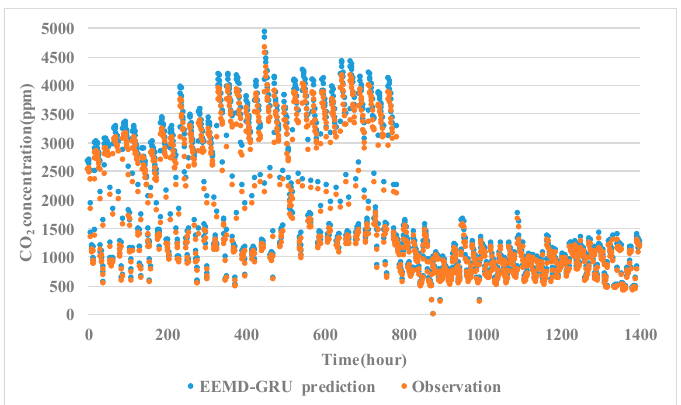
Figure 9. Scatter plot of EEMD–GRU model. Note: The data on the left are autumn and winter, the data on the right are spring and summer.